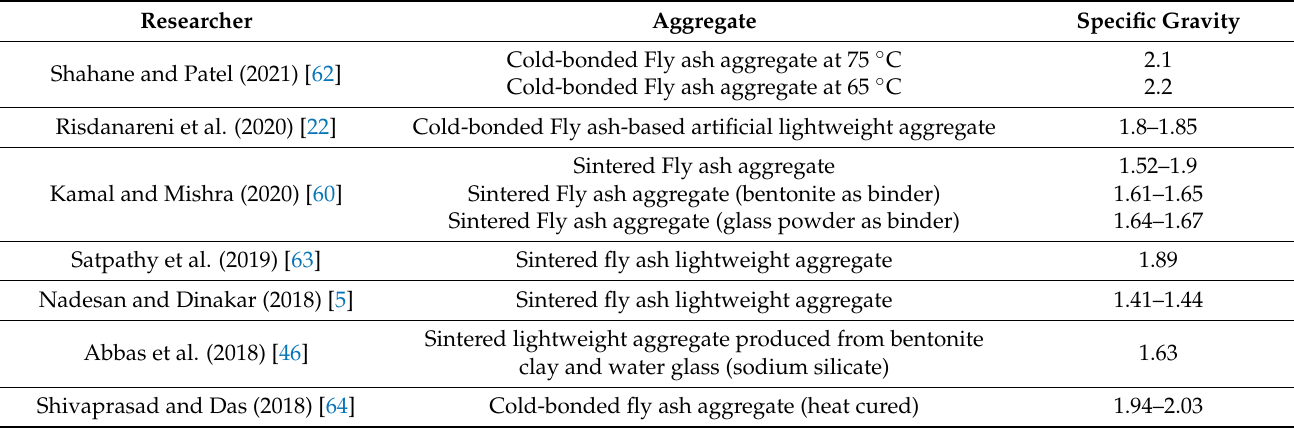
Table 2. Previous studies on specific gravity of lightweight